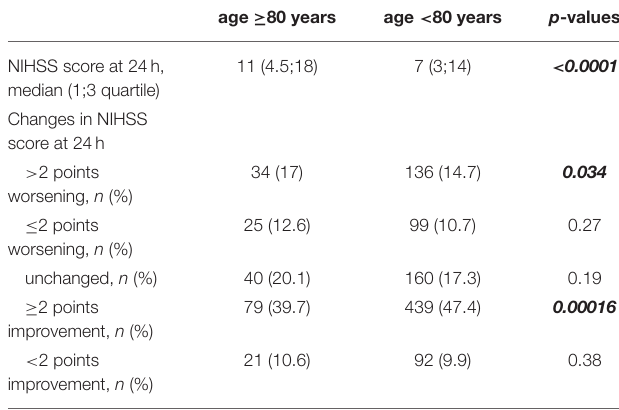
TABLE 4 | Median NIHSS scores and changes in NIHSS at 24h in patient groups above and under 80